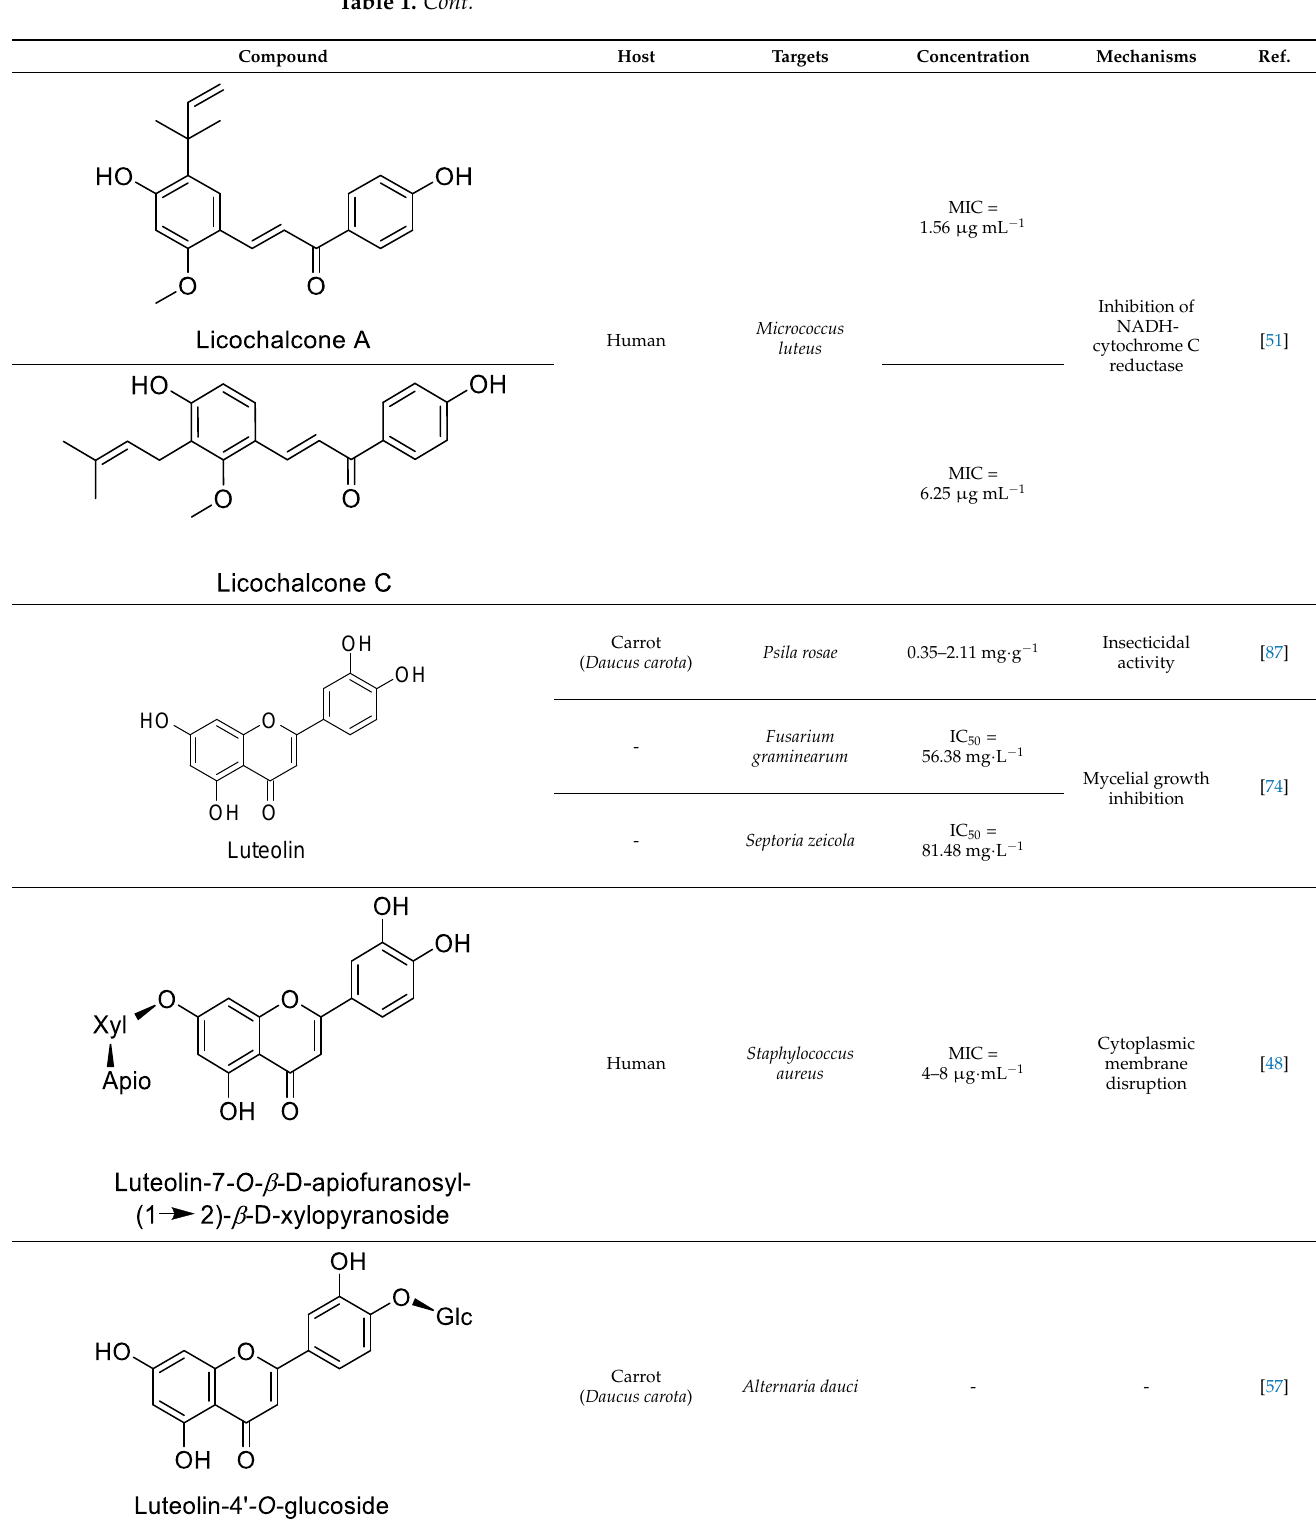
Table 1. Cont. Compound Host Targets Concentration Mechanisms